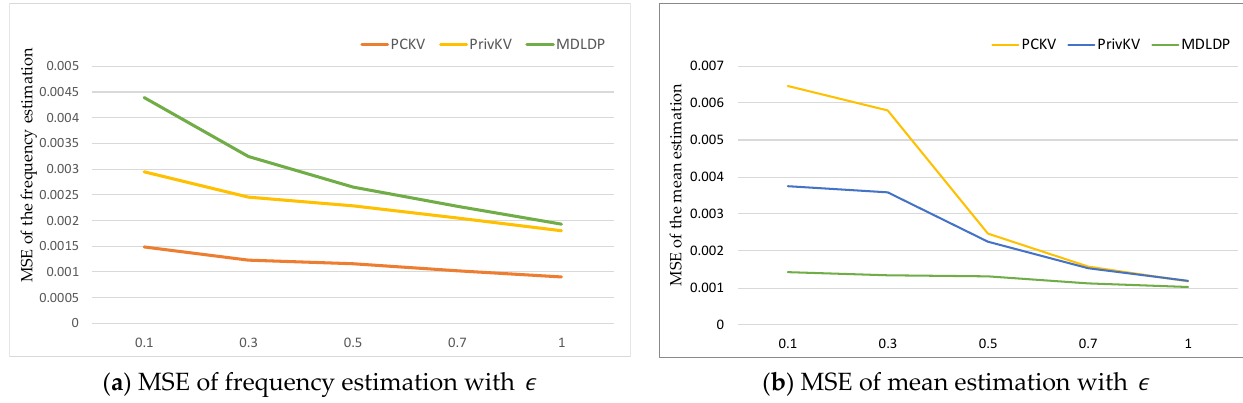
Figure 10. MSE of the frequency estimation and mean estimation with different ϵ . Figure 11a–d present the RE of the top 10–50 elements’ frequency estimation for privacy budgets (cid:101) of [ 0.1, 0.3, 0.5, 0.7 ] . It can be seen from these figures that (1) the relative error of the statistics rises with the number of statistics; (2) the proposed algorithm has a higher accuracy under the same privacy